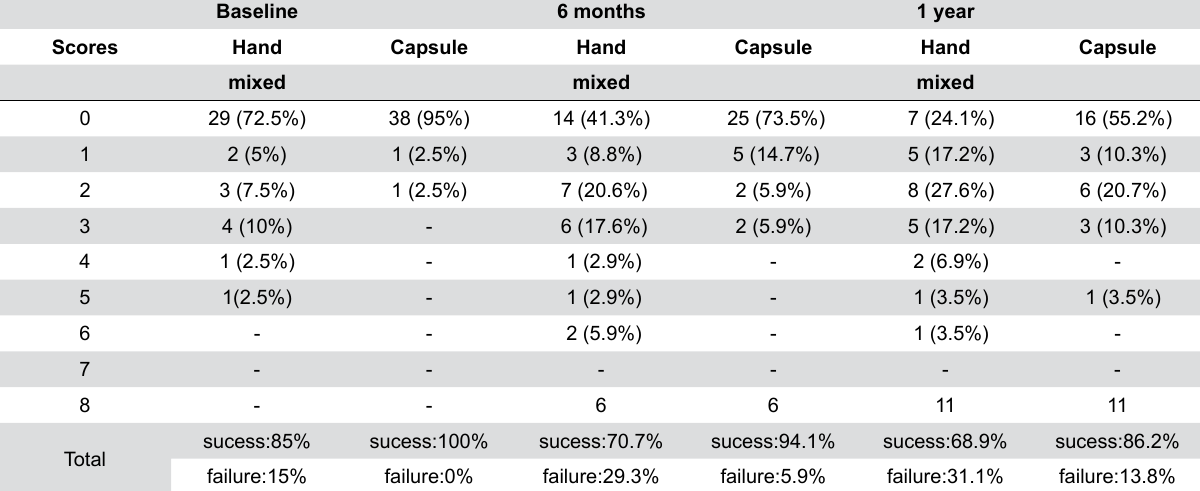
Table 3- Distribution of Atraumatic Restorative Treatment (ART) scores, according to the evaluated groups at baseline, 6 months, and 1